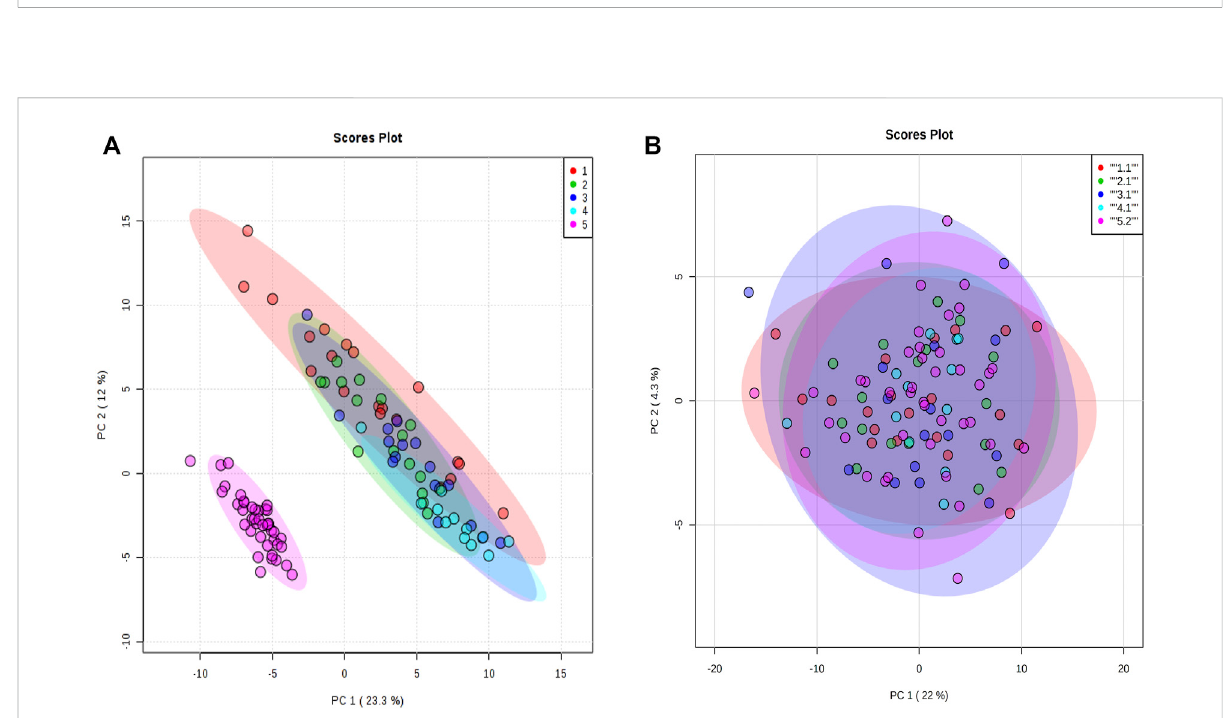
Principal component analysis of proteomic data. (A) Principal component analysis with all animals normalized together. (B) Principal component analysis when animals were normalized separately by equipment acquisition. The colors denote the equipment batch effect. The samples in red, green, dark blue, and blue colors are from equipment 1. The samples in pink are from equipment